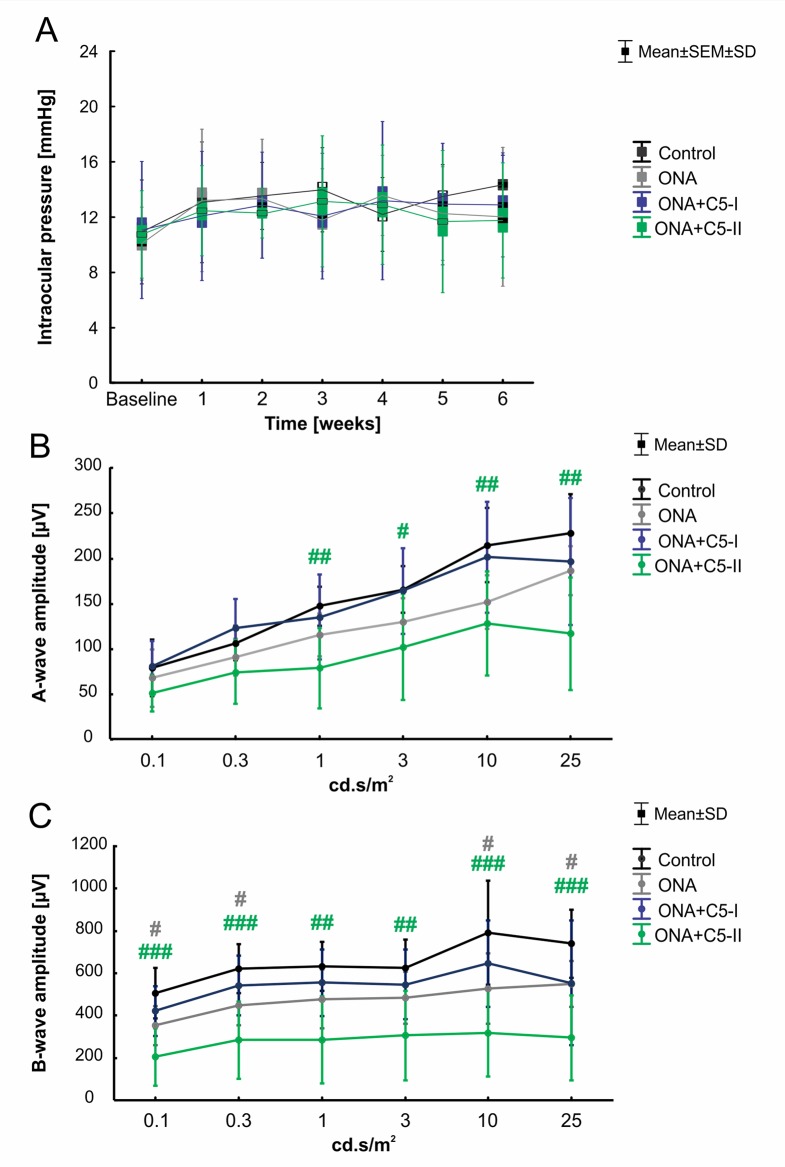
Unaltered intraocular pressure and improved retinal function after C5 administration. (A) The IOP of the animals was measured before (baseline) and once every week after the immunization. No significant differences between the control, the ONA, and both treatment groups were observed at all points in time. (B) The a-wave amplitudes of the ERG measurements at all light intensities. At 1-25 cd.s/m2, a significant decrease was noted in ONA+C5-II animals compared to controls (p < 0.05). (C) The b-wave amplitudes of the ERG measurements at all light intensities. A significant lower amplitude was observed in ONA retinae compared to controls at 0.1, 0.3, 10, and 25 cd.s/m2 (p < 0.05). At all light intensities, the b-wave amplitude of ONA+C5-II was significantly decreased in comparison to controls (p < 0.01). Values for IOP are mean ± SEM ± SD. Values for ERG are mean ± SD. Grey# = ONA vs control; green# = ONA+C5-II vs control. #p < 0.05, ##p < 0.01, ###p < 0.001.